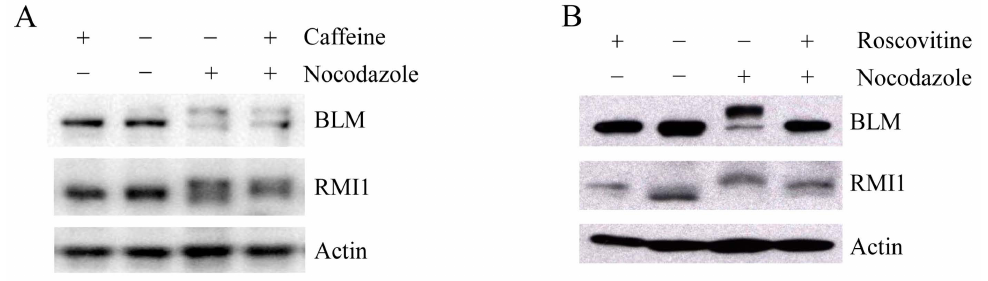
Figure 6. Mitotic RMI1 phosphorylation is partly reversed after roscovitine treatment. HeLa cells were left untreated or treated with nocodazole for 18 h. Thereafter, caffeine ( A ) or roscovitine ( B ) was added for 2 h. Cell lysates were analyzed by Western